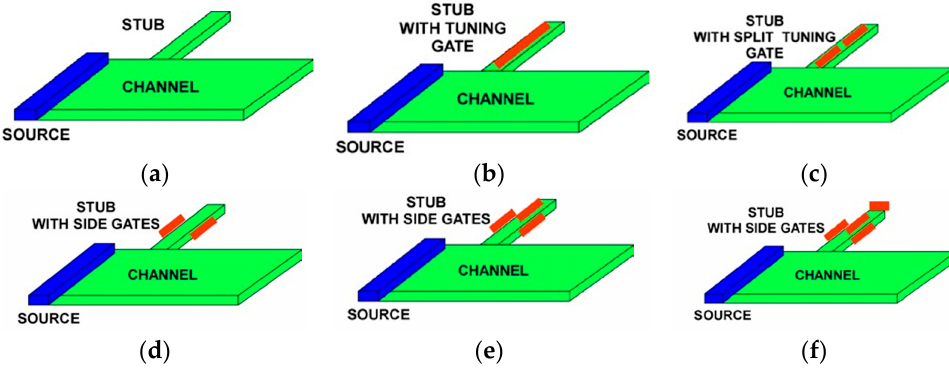
Figure 8. Stubs for tuning: ( a ) ungated stub; ( b ) stub with a single tuning gate; ( c ) stub with a split tuning gate; ( d ) stub with side gates; ( e ) stube with side gates and top gate; ( f ) stub with side gate and two top tuning gates.